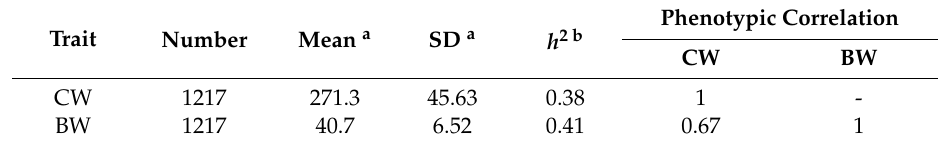
Table 1. Descriptive statistics of carcass weight (CW) and bone weight (BW) in the Chinese Simmental beef